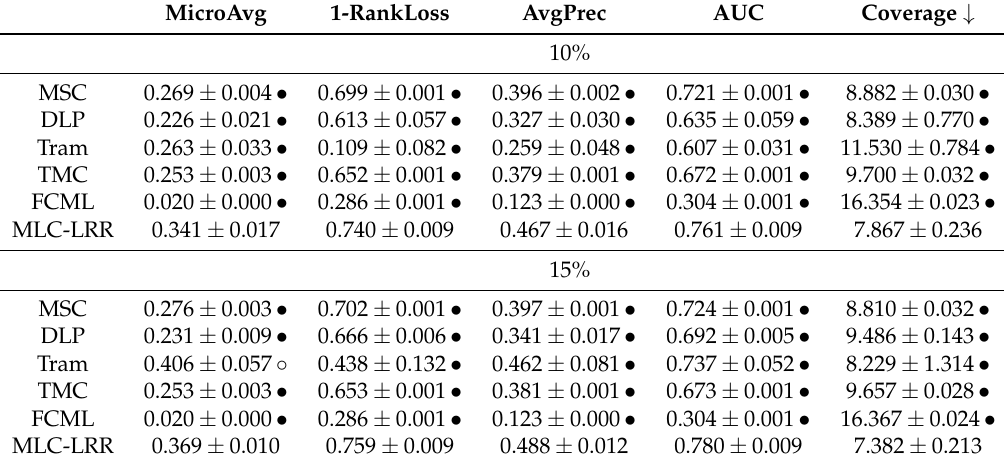
Table 3. Experimental results (mean ± std) on the Land Cover dataset with 10% and 15% labeled images. DLP, Dynamic Label Propagation (DLP); TMC, Transductive Multi-label Classifier. • / ◦ indicates whether MLC-LRR is statistically (pairwise t -test at 95% significance level) superior/inferior to the comparing methods under a particular evaluation metric.